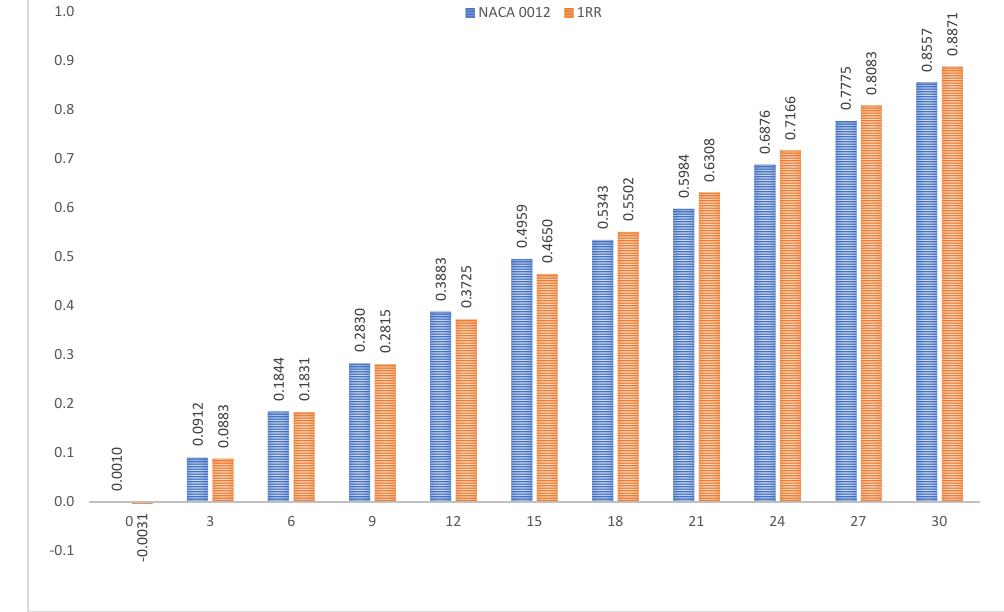
Figure 3. Lift analysis. ( a ) Pressure pathlines of NACA 0012. ( b ) Pressure pathlines of 1RR HPBA. ( c ) Lift generated at all angles of attack. ( d ) Lift increment in percentage.